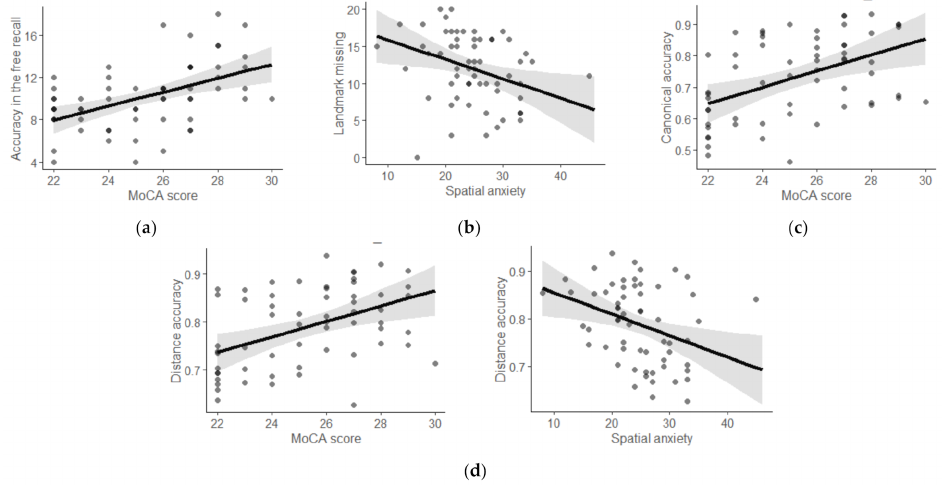
Figure 3. Significant predictors’ effects in the regression models. ( a ) MoCA scores for free recall; ( b ) spatial anxiety in map drawing–missing landmark; ( c ) MoCA scores for canonical accuracy; and ( d ) MoCA scores and spatial anxiety for distance